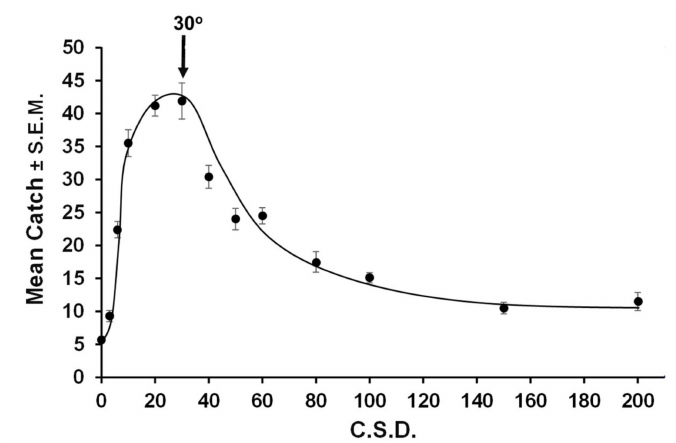
Figure 4. Catch as a function of circular standard deviation (c.s.d.) by populations of 5000 movers randomly seeded within a starting arena of 1000 × 600 units of an unbounded cyber arena, where they took 3000 steps with one 2 × 2 units trap at its